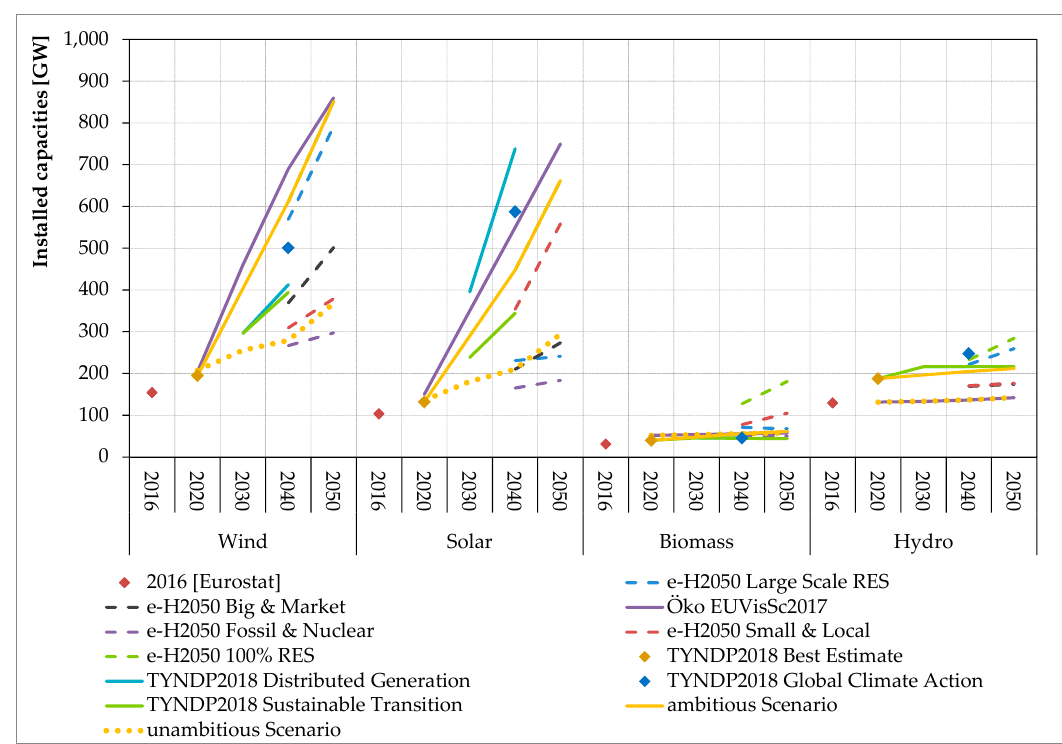
Figure 15. Installed RES-E capacities in EU 28 countries. Sources: References [5,29–31,33]. Figure A3. Installed RES-E capacities in EU 28 countries. Sources: References